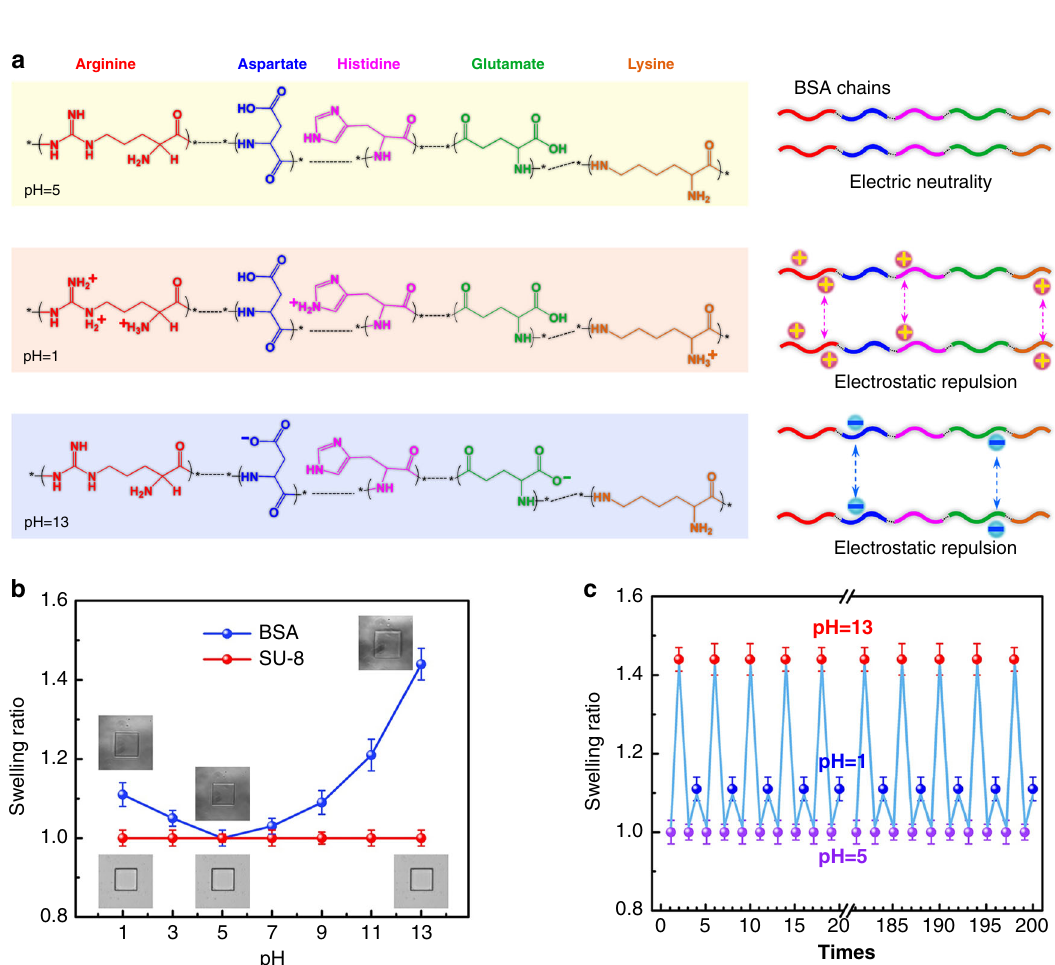
Fig. 1 Scheme of the successive on-chip TPP strategy and a proof-of-concept spider microbot. a Schematic illustration for the femtosecond laser programmable fabrication of the musculoskeletal systems. (i) TPP fabrication of the 3D SU-8 body and skeleton structure for eight legs; (ii) in situ development of the spider body and skeleton; (iii) secondary integration of the pH-responsive BSA muscles via TPP. b , c SEM images of the micro-spider before and after the integration of BSA muscles, respectively. The insets correspond to their optical microscopy images, and the blue parts in the latter one indicates the presence of BSA muscles at the joints of the legs. d – f Detailed SEM images of the joints where the BSA muscles were well integrated. g The actuation of the micro-spider when the pH value was switched from 13 to 5. The pro fi les of the micro-spider in this actuation are marked in red, yellow, and green, respectively. The superposition of the contour pro fi les (right image) at different time is provided for comparison.